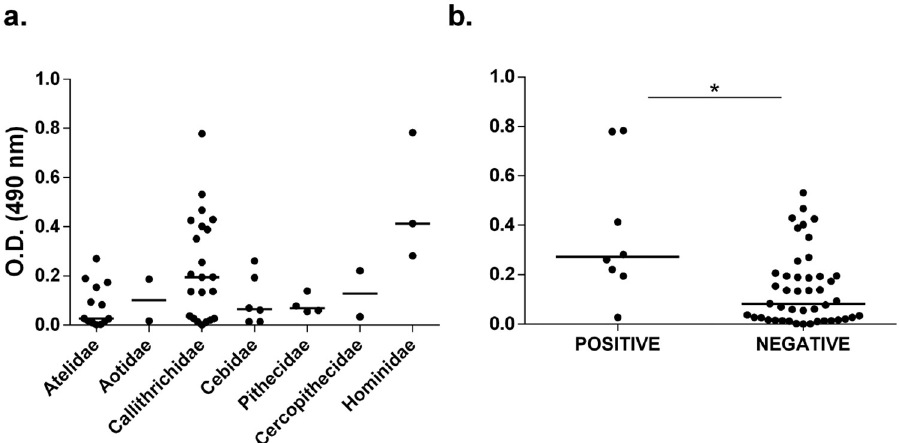
Fig 3. ELISA anti- Lutzomyia longipalpis saliva. (A) O.D. from each non-human primate evaluated distributed according their families. (B) O.D. from non-human primates grouped in positive and negative to Leishmania spp. by xenodiagnosis. Positive animals had statistically significant higher O.D. values when compared to negative animals ( � p = 0.0049 –Mann-Whitney test). Line represents the median and dots indicate individual values. https://doi.org/10.1371/journal.pntd.0007313.g003 Table 3. Phlebotomines captured within the area of the Zoological Garden in Belo Horizonte (Brazil), from February 2014 to February 2015. Legend: # Pools: indi- cate the number of pools from each phlebotomine species that were prepared for DNA extraction. Species # Specimens # Pools Male Female Total